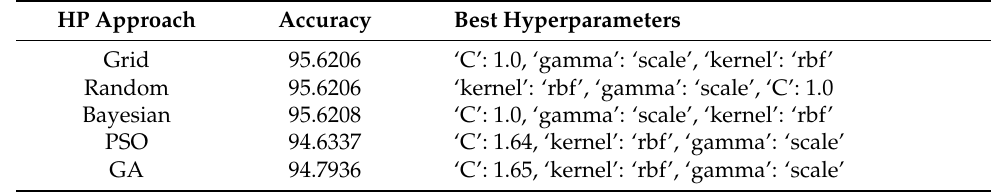
Figure 14. Score per parameter for Random Forest (RF). Table 5. Hyperparameter tuning for Support Vector